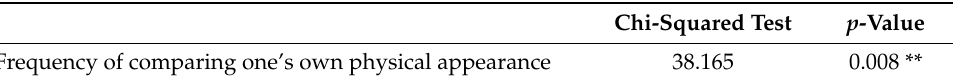
Table 5. One-way ANOVA results looking for a link between EDI-BD score and level of education. Estimates p -Value Intercept 13.620